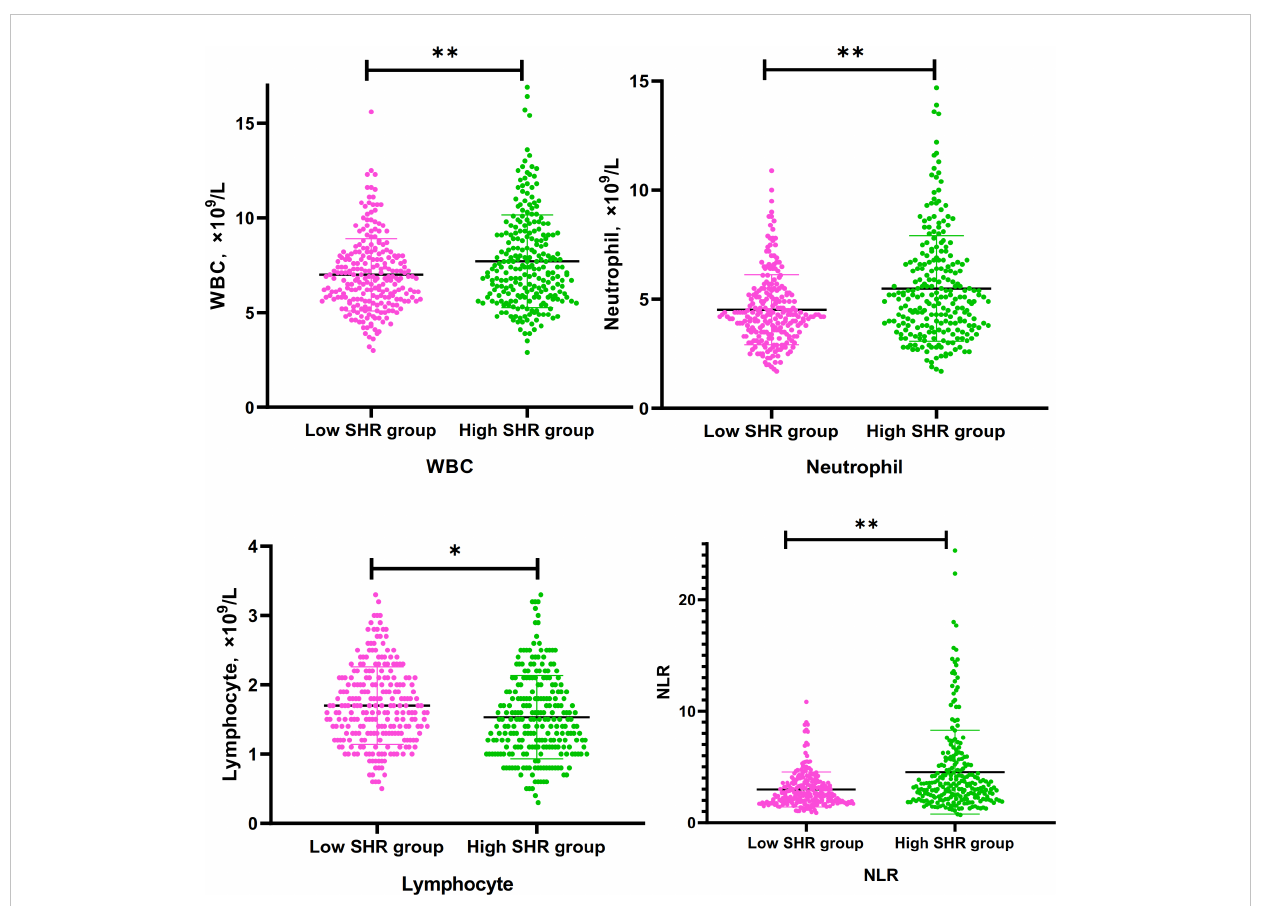
FIGURE 1 Differences of WBC, Neutrophil. lymphocyte, and NLR between low SHR group and hig SHR group. SHR-fasting blood glucose (mmol/L)/HbA1c (%); WBC, white blood cells; NLR, neutrophil-to-lymphocyte ratio. *P<095; **p<0.001.